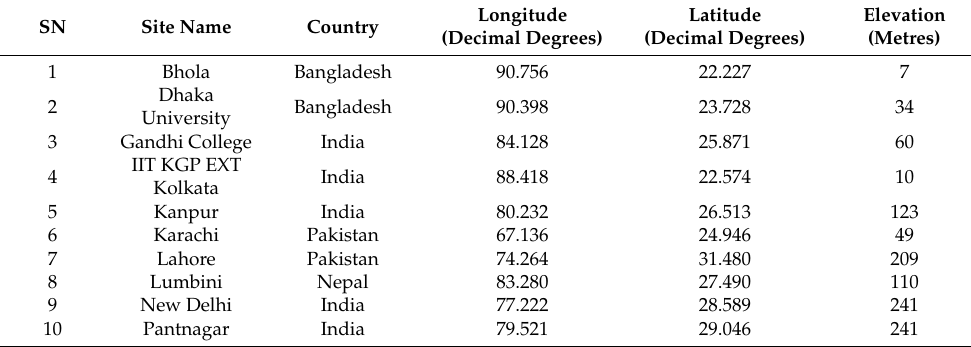
Table 1. AERONET Stations in the